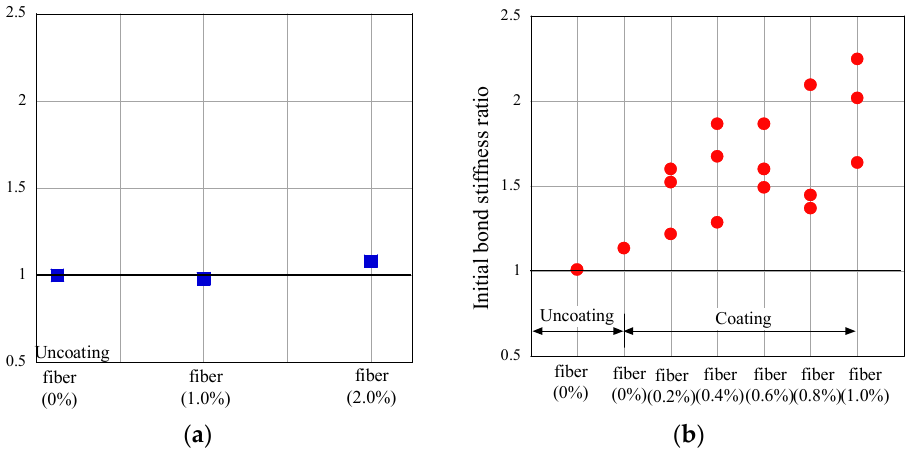
Figure 11. Comparison of the initial bond stiffness ratios: ( a ) uncoated rebars [32]; ( b ) UHPC-coated rebars.